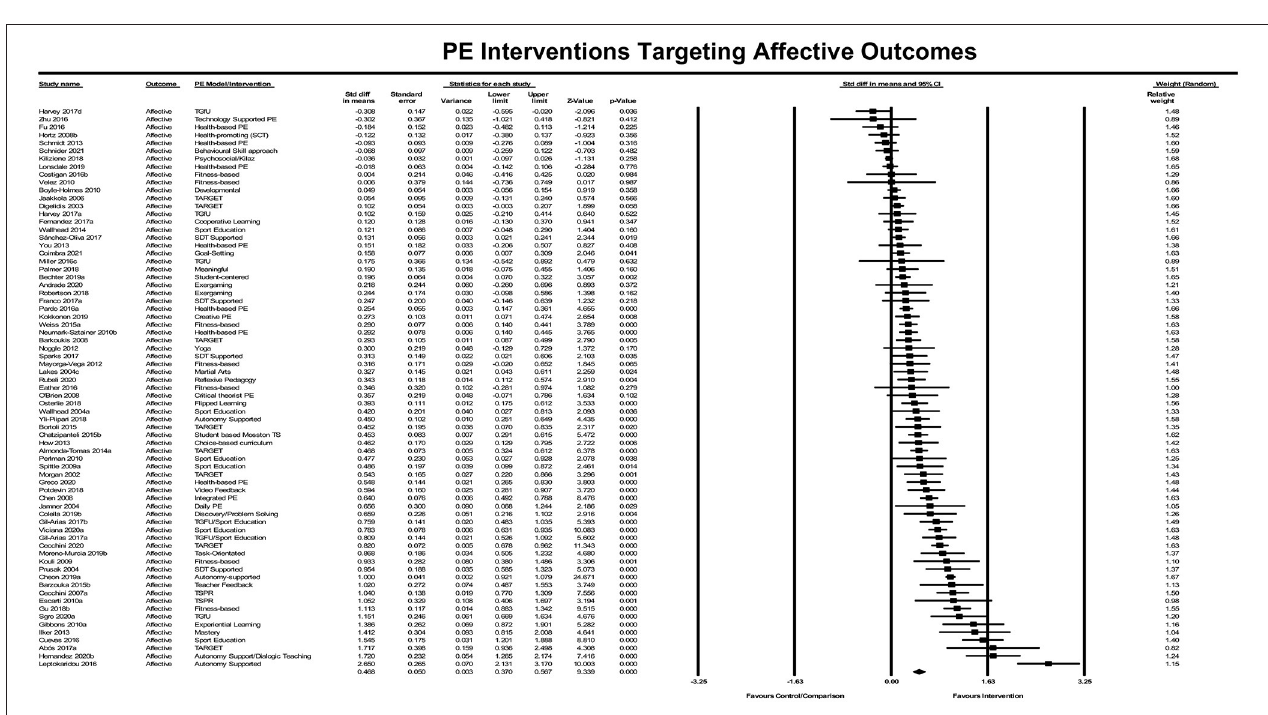
FIGURE 8 | Funnel plot of standard error by standardized difference in means of psychomotor PE interventions.